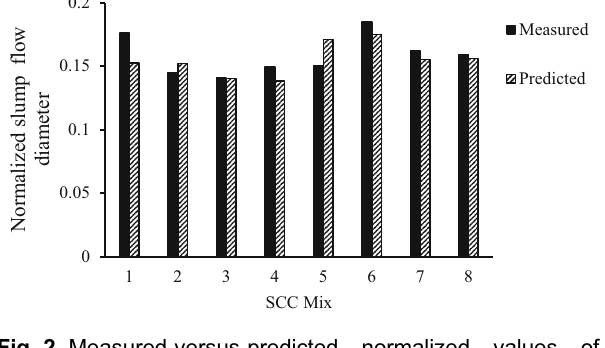
Fig. 2 Measured-versus-predicted normalized values of slump flow.